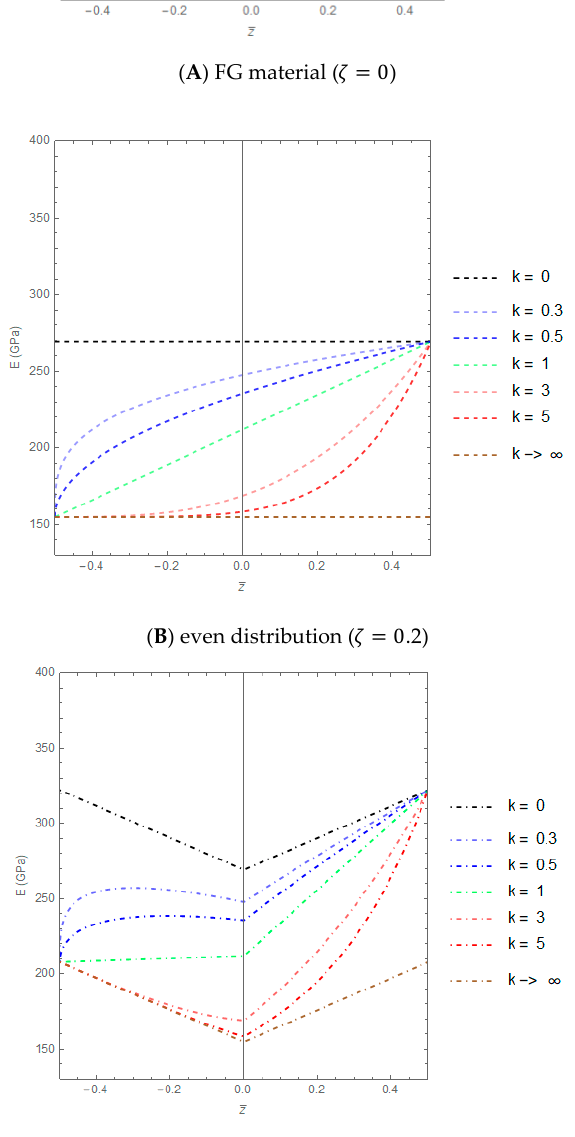
Figure 5. Variations of the Euler–Young modulus ( E ) in terms of dimensionless thickness (𝑧̃ = 𝑧/ℎ) with k ranging in the set {0, 0.3, 0.5, 1, 3, 5, → ∞ } and 𝜁 = 0 .2: ( A ) FG material (continuous lines); ( B ) even distribution (dashed lines); and ( C ) uneven distribution (dashed-points lines).